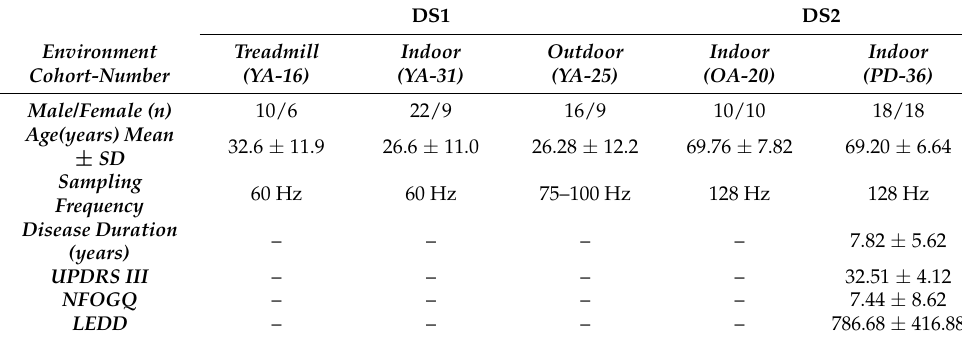
Table 1. Participant information/experimental